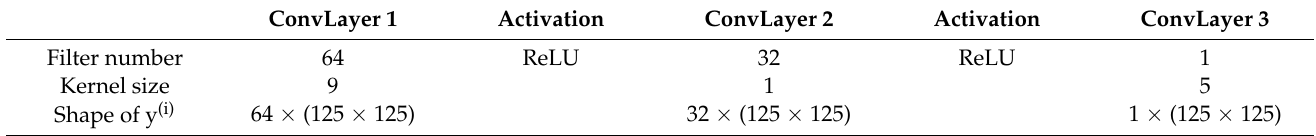
Figure 3. Proposed C convolutional neural network (CNN) architecture for the downscaling of normalized difference vegetation index (NDVI). Table 1. Hyper-parameters of the proposed CNN. y (i) represents the variable in the equations of Figure 3.